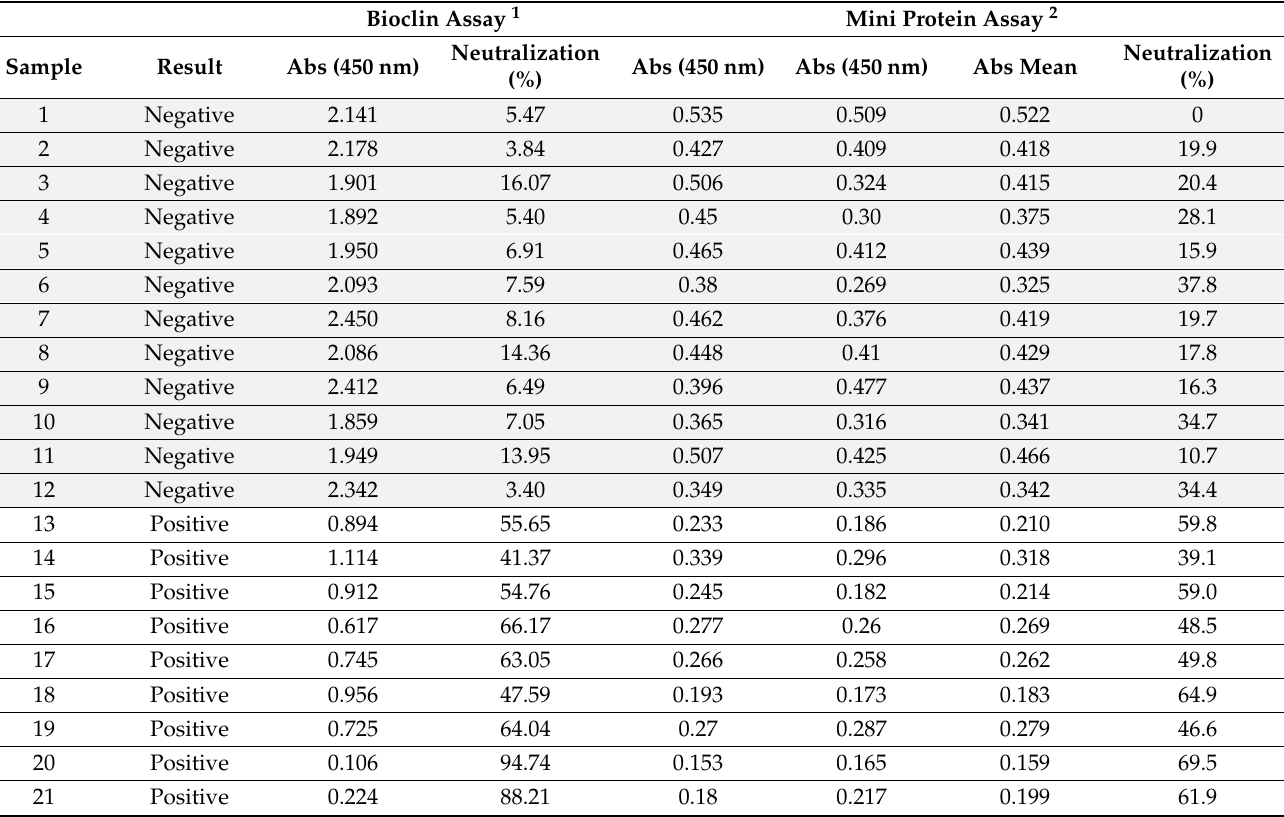
Table 1. Neutralizing antibody ELISA